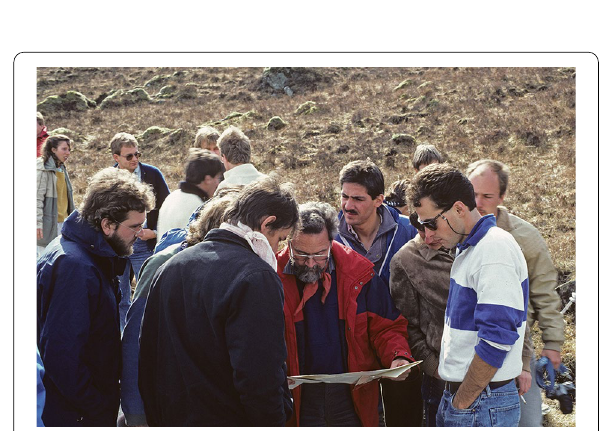
Fig. 2 John Ramsay during an excursion and mapping course in Scotland, 1986 (Image: Neil